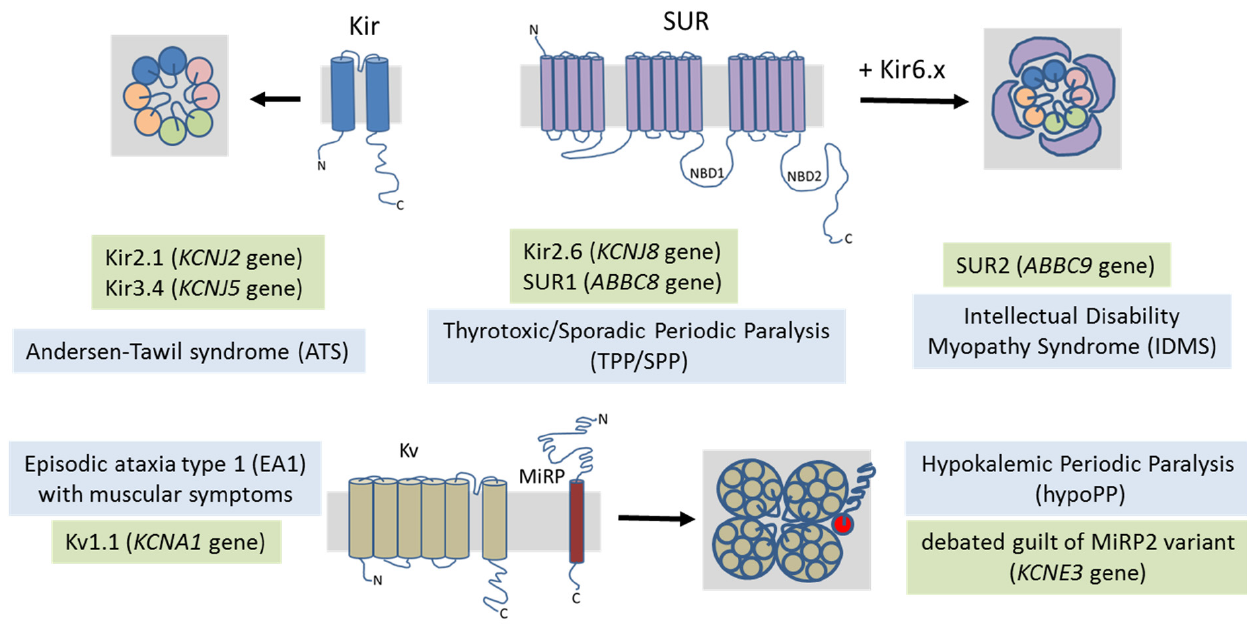
Figure 3. A schematic representation of the potassium channels involved in skeletal muscle myopathies. Potassium channel subunits are represented in lateral view embedded in the membrane, while multimeric assemblies are represented from the top view. The inward-rectifier K + channels are heterotetrameric assemblies of Kir subunits. The ATP-sensitive K + channels are made by the octameric association of four Kir6.x subunits with four sulfonylurea receptors (SUR) containing nucleotide-binding domains (NBD). The voltage-dependent K + channel Kv1.1 is expressed in neurons, but a number of EA1 patients may present with predominant muscular phenotypes. The pathogenicity of the K + channel auxiliary subunit MirP2 in hypoPP is still debated.